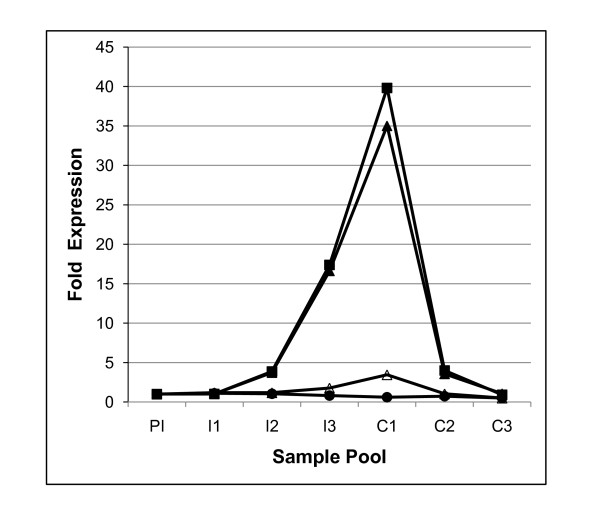
Analysis of transcript levels of Th2 effector cytokines. The level of IL-4 (open triangle), IL-5 (black square), IL-13 (black triangle) and IFNγ (black circle) transcripts in sample pools were measured by qRT-PCR. Expression levels were normalised to PI level. PI = week 0, I1 = week 1, I2 = week 4, I3 = week 7, C1 = week 10, C2 = week 11, C3 = week 12.